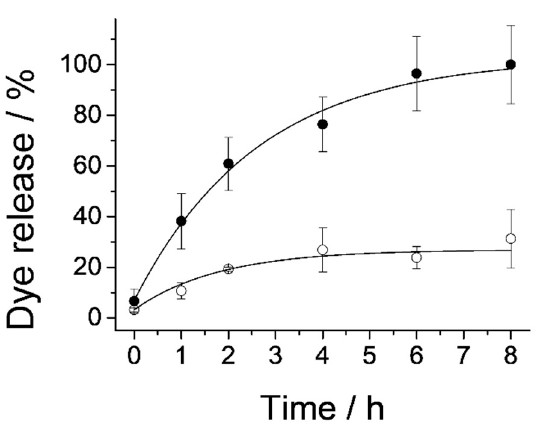
Figure 5. Cargo release profiles of RhB from M41–RhB–Z in H 2 O at pH 8 ( ⚪ ) and when proteolytic enzymes (pronase) are present ( ● ). Release assays were performed in triplicate, and error bars correspond to the standard deviation.